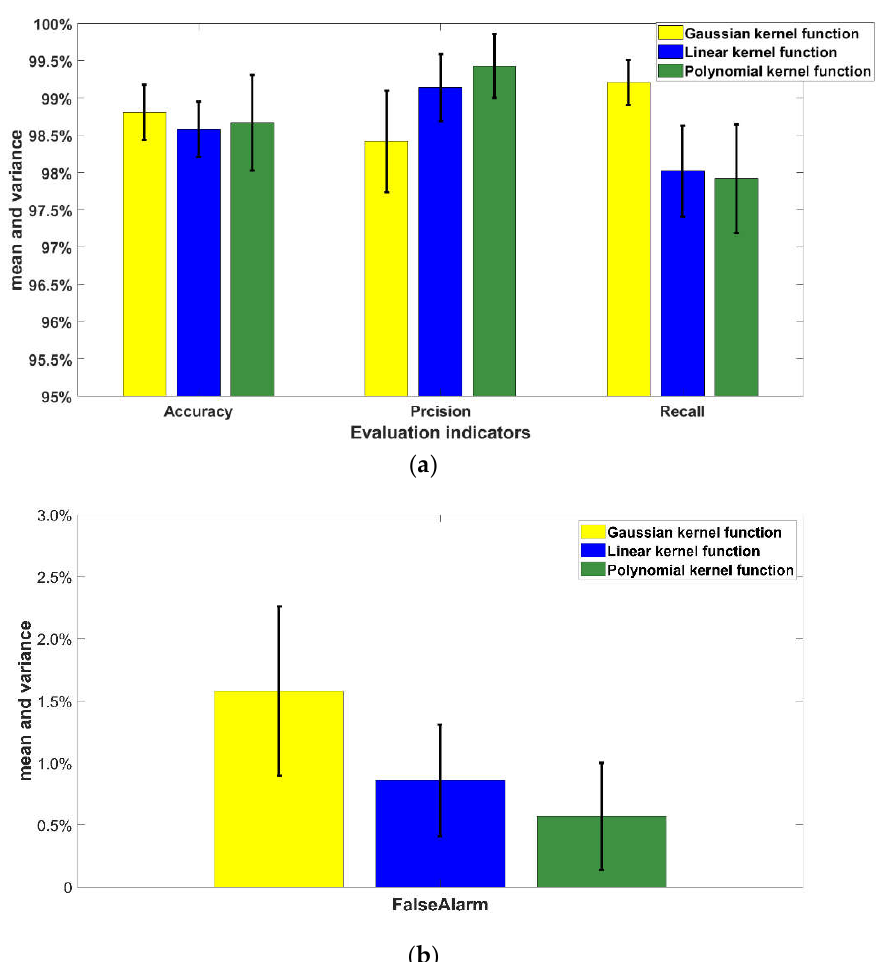
Figure 8. Histogram of experimental results. ( a ) Accuracy, precision, and recall experiment results. ( b ) FalseAlarm experiment results.